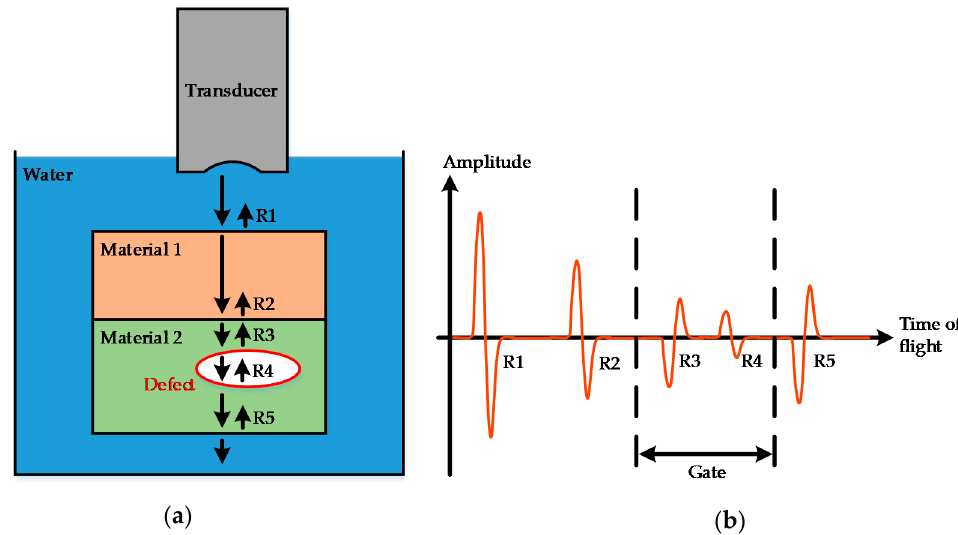
Figure 2. ( a ) Simplified setup of scanning acoustic microscopy (SAM). Transducer and specimen (Two di ff erent materials with a defect in material 2 are placed in water as a couplant. An acoustic wave is emitted by the transducer toward the specimen, and the potential received echo of the wave for this material stack is shown in ( b ). The echo consists of back reflections of the wave at any material interface arriving with di ff erent propagation delays according to their depth in the stack. In this example, the reflections are caused by the interfaces from water to material 1 (reflection R1), from material 1 to material 2 (R2), from material 2 to defect (R3), from defect to material 2 (R4), and from material 2 to water (R5), and they arrive in this order at the transducer. A time gate is set between R2 and R5, which contains all reflections of defects in material